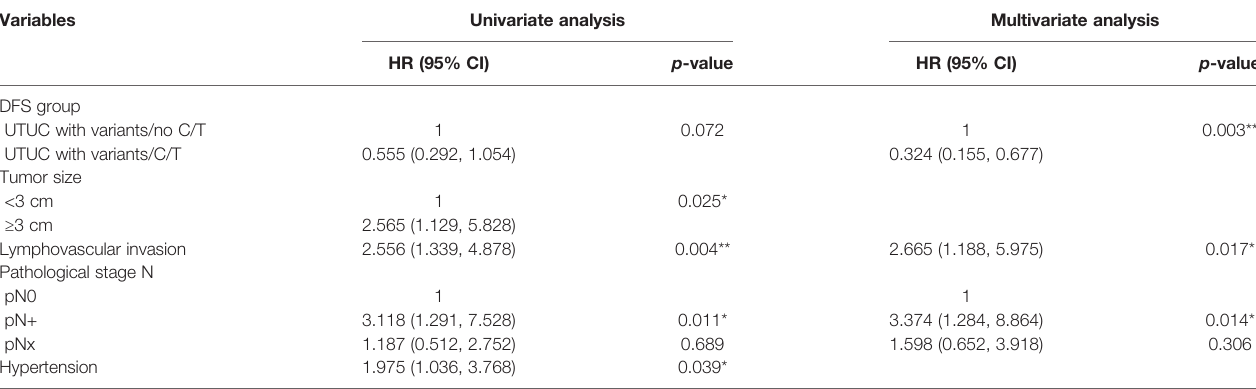
TABLE 5 | Univariate and multivariate regression disease-free survival (DFS) analyses in patients with variant upper tract urothelial cancer (UTUC) undergoing radical nephroureterctomy